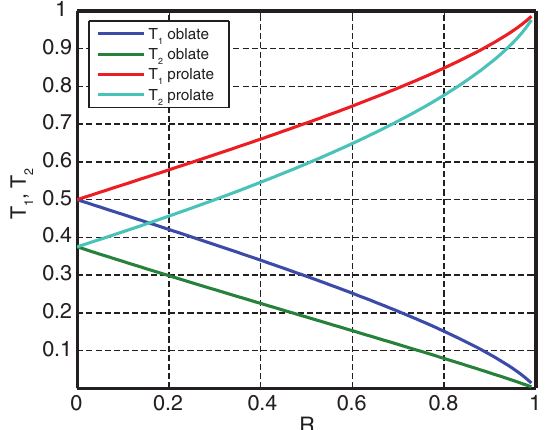
Figure 10. Dependencies of polarizability ratio ρ e on axis ratio of a spheroid ρ g for different densities of ice.